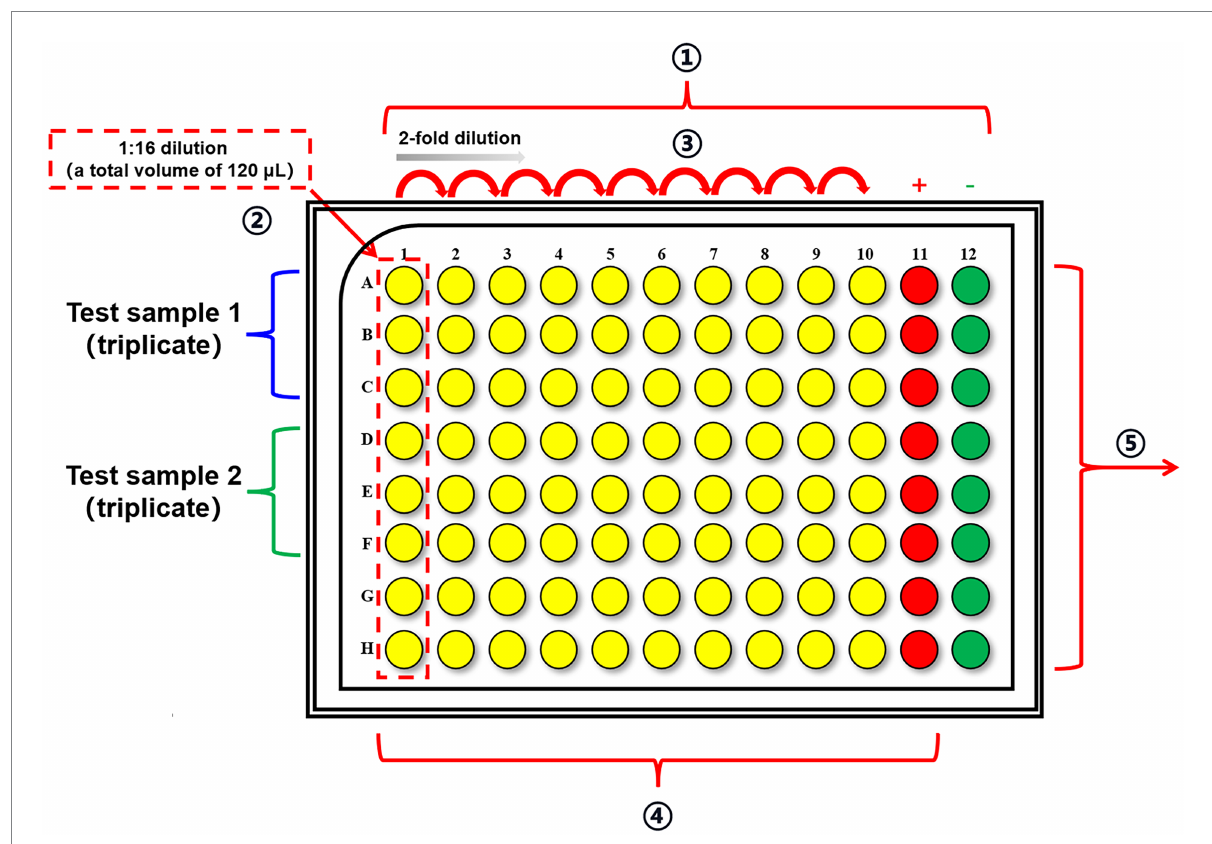
FIGURE 2 The layout of U-shaped 96-well plates for incubation of samples and viruses. ① Add 112.5 μ l serum-free DMEM to column 1 and 60 μ l serum-free DMEM to columns 2–12 in U-shaped 96-well plates. ② Add 7.5 μ l of test samples to each well in column 1 and each sample is in triplicate.